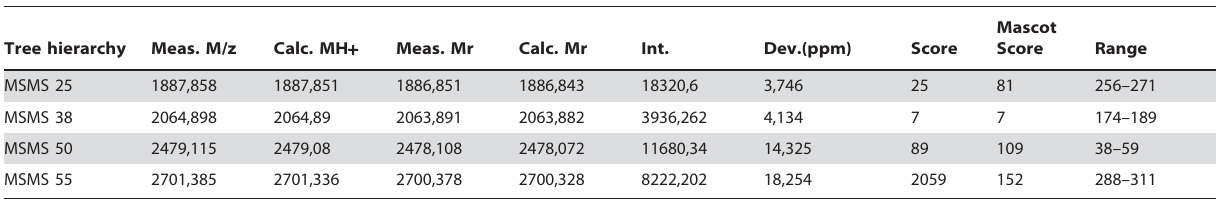
Table 2. MS/MS results for Calumenin identification.